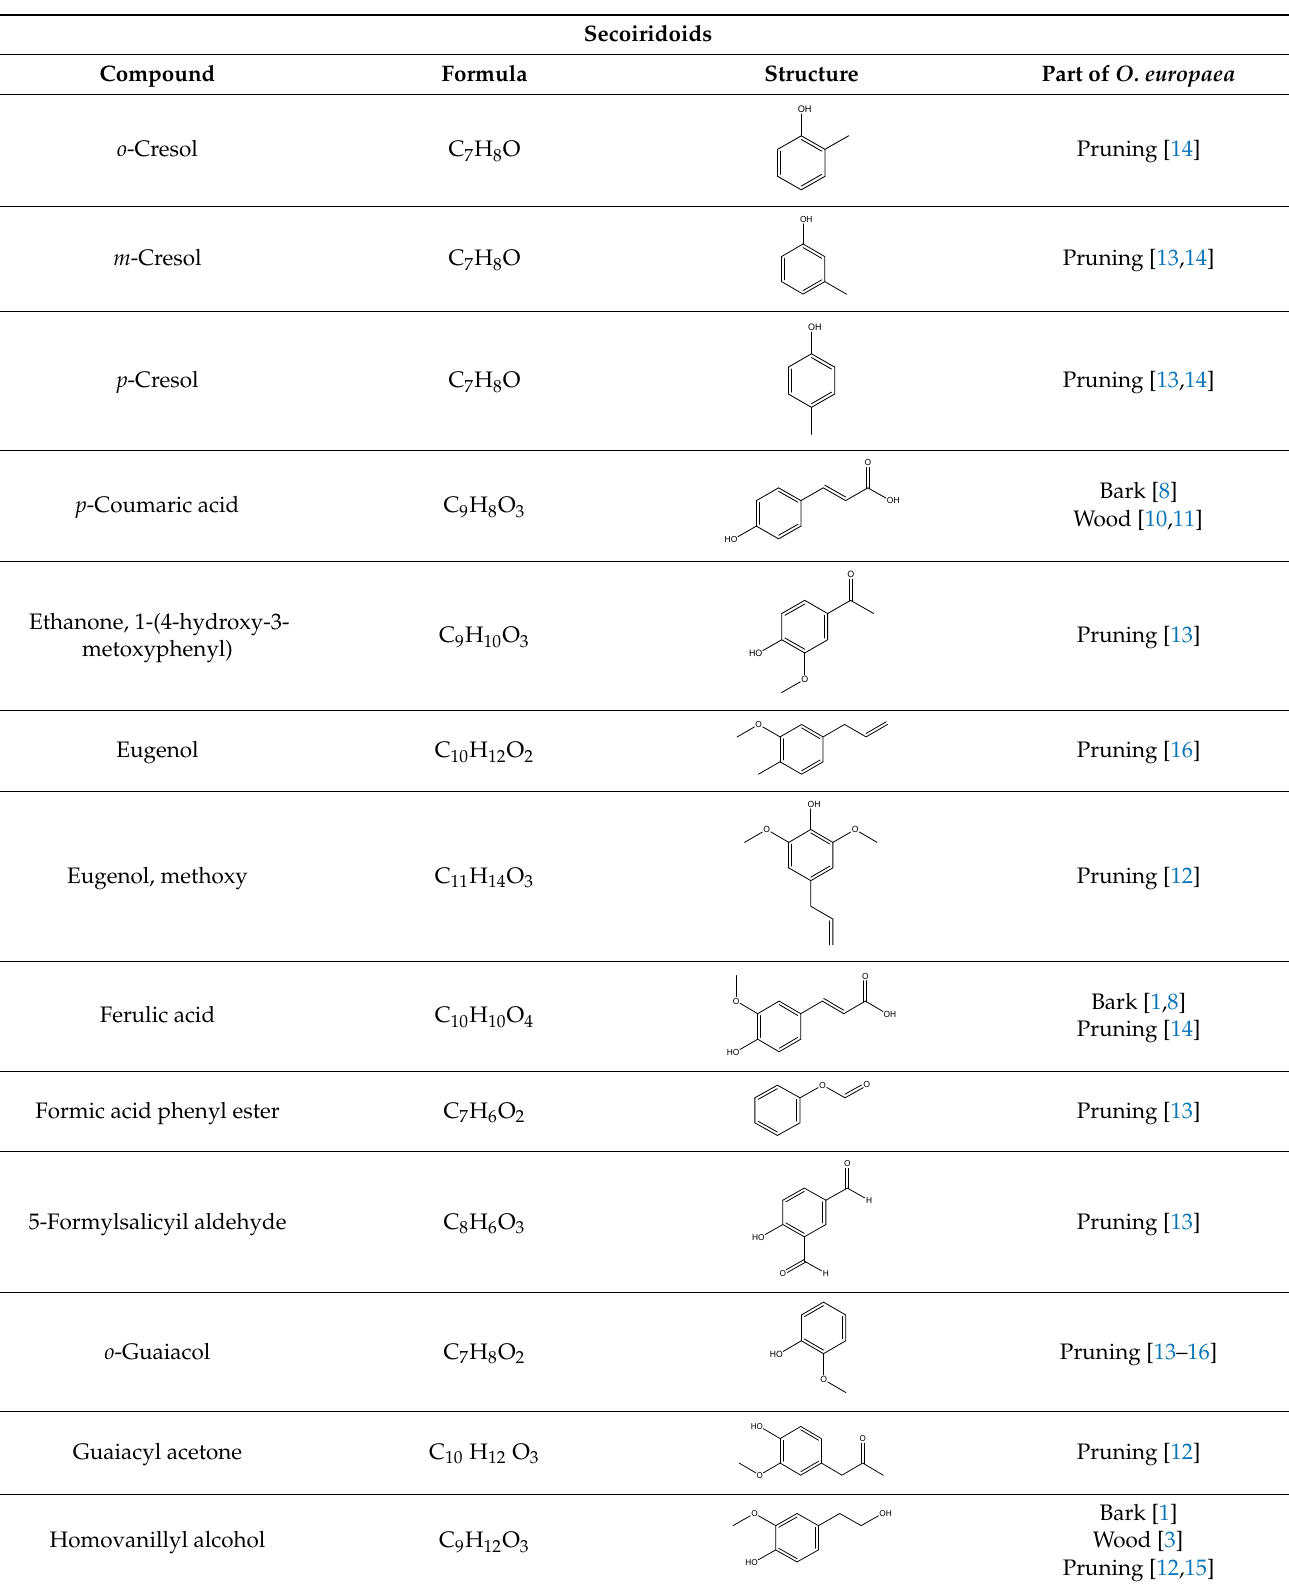
Compound Formula Structure Part of O.